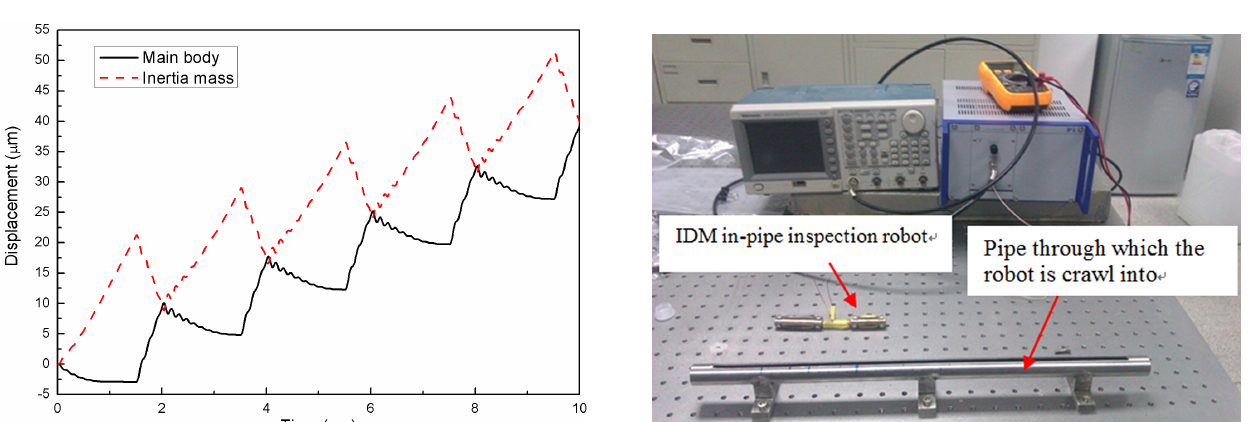
Figure 6. The schematic diagram of the signal flow.